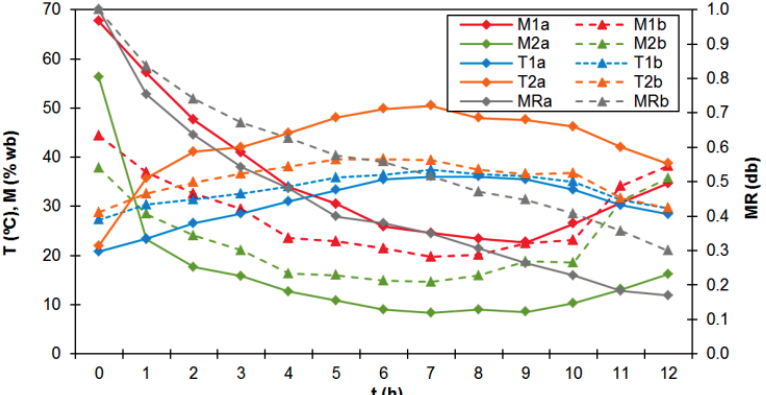
Figure 16. T , M and MR variation of SLG for two